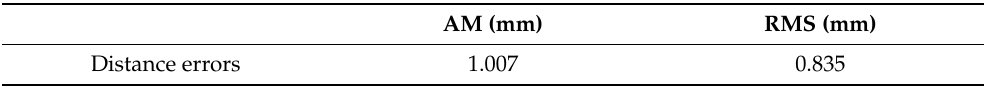
Table 3. The distance errors of the reconstructed scale bar. Figure 14. The points on the workpiece reconstructed by the VMOS and measured by TriTop ® .